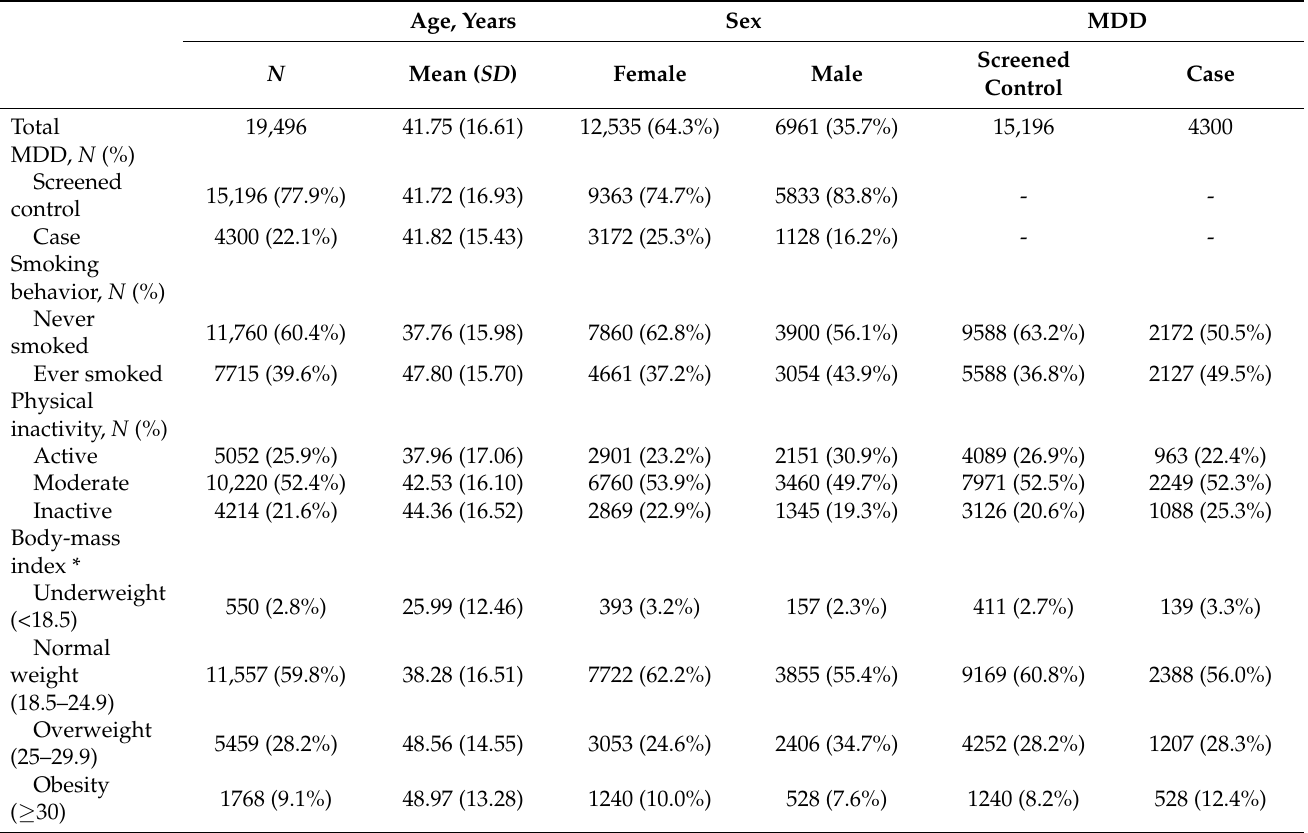
Table 2. Demographic and phenotypic descriptives of extended twin pedigree data. MDD = major depressive